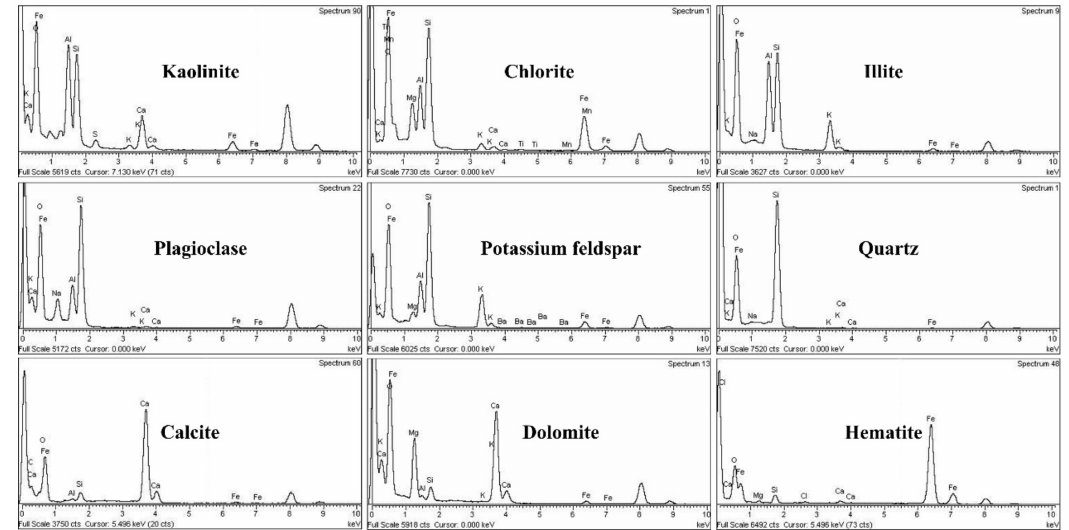
Figure 3. Different minerals detected by EDX during the dust storm.